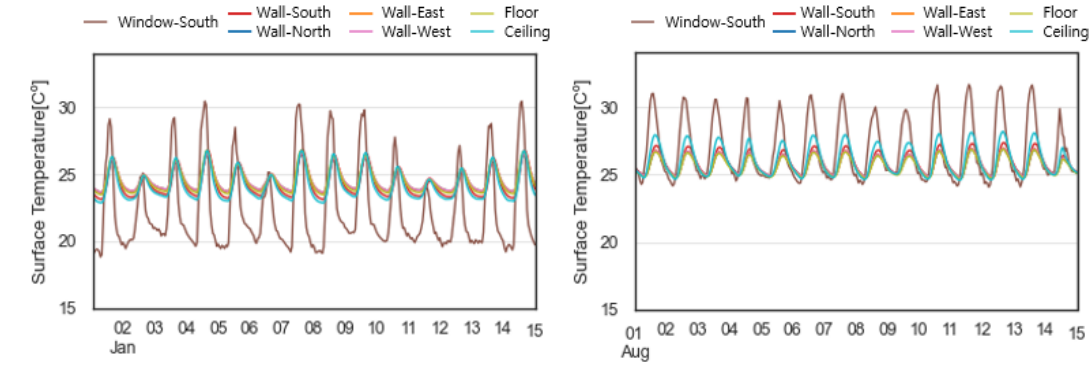
Figure 5. Simulation results: Indoor surface temperature: Winter ( left ), summer ( right ).